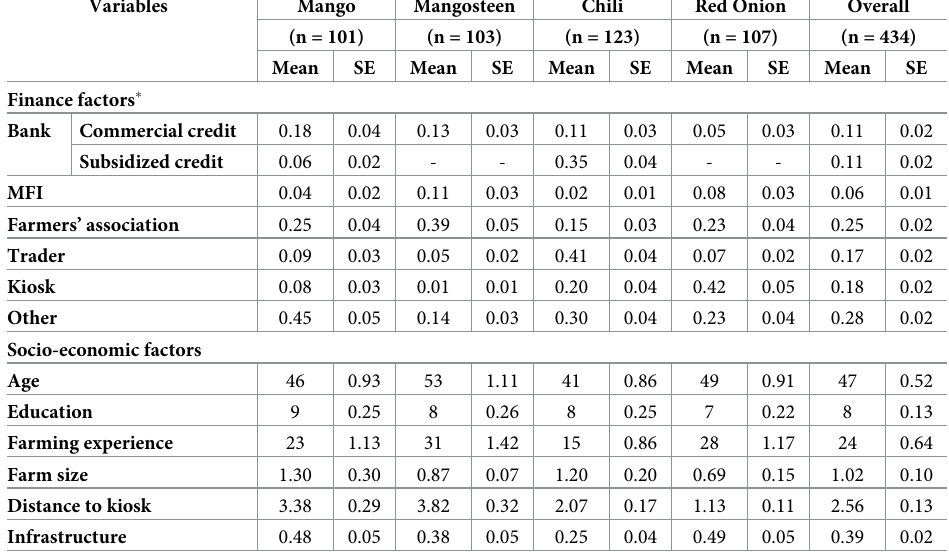
Table 1. The characteristics of